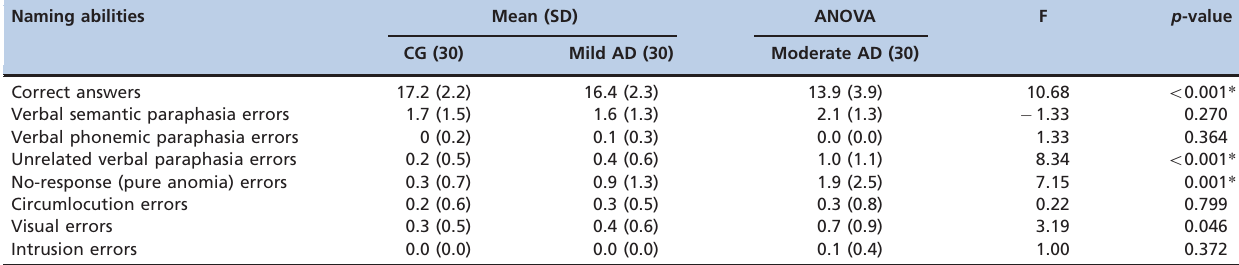
Table 1 – Descriptive analysis based on the mean measurements of naming abilities and the ANOVA results. Naming